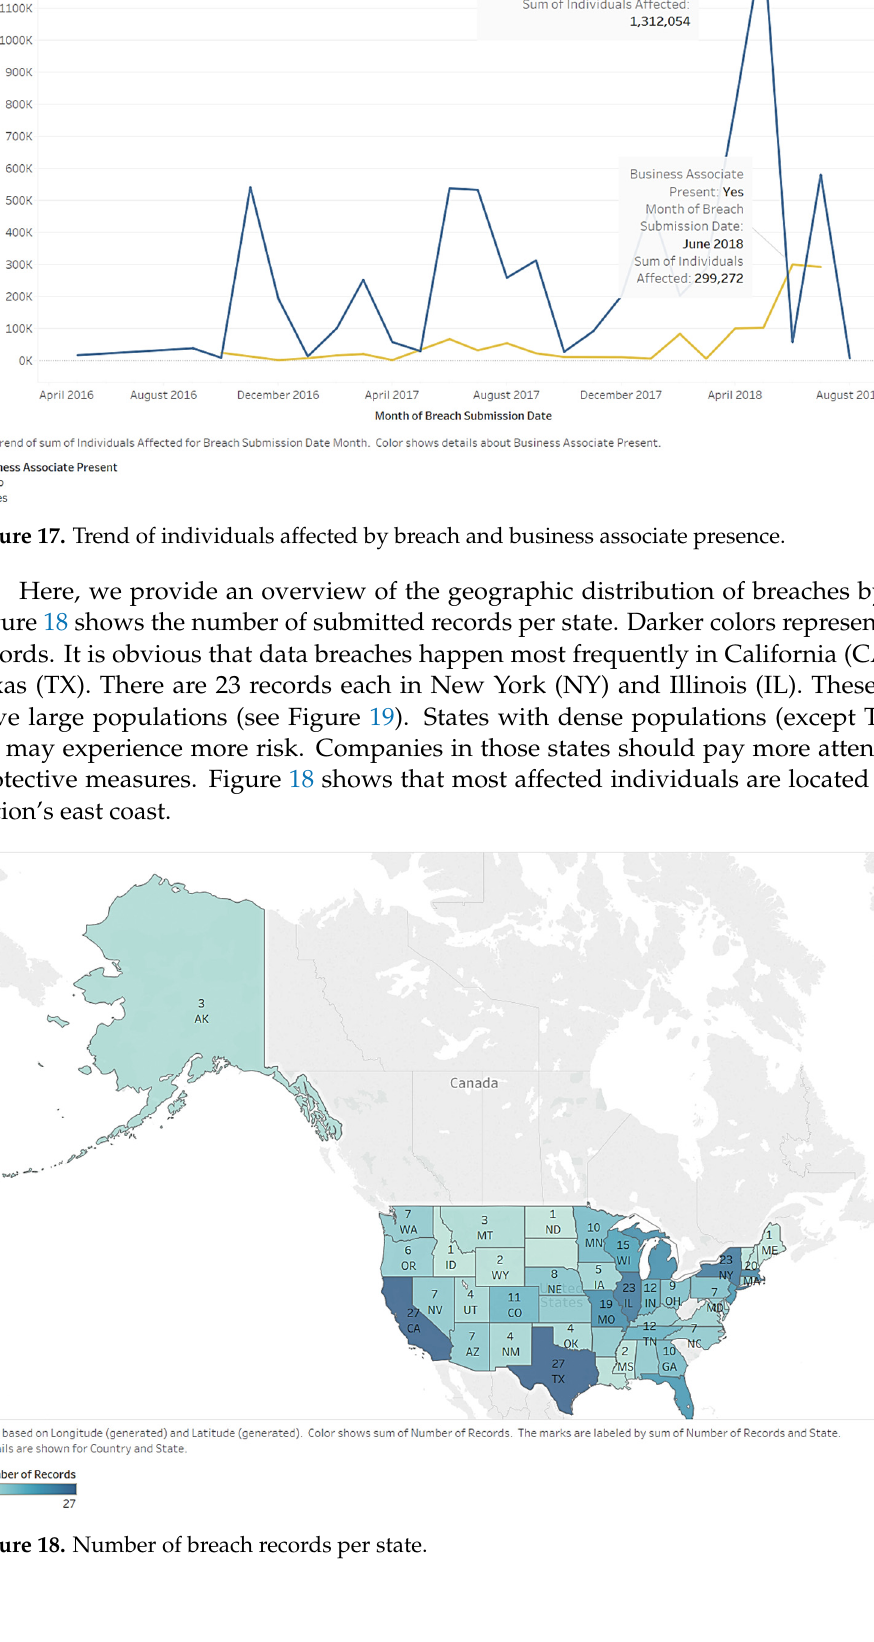
Figure 19. Number of affected individuals and state population. Figure 20 describes the distribution of healthcare breaches by state. The different col- ors show the number of records. Darker shades represent a higher number of records. The